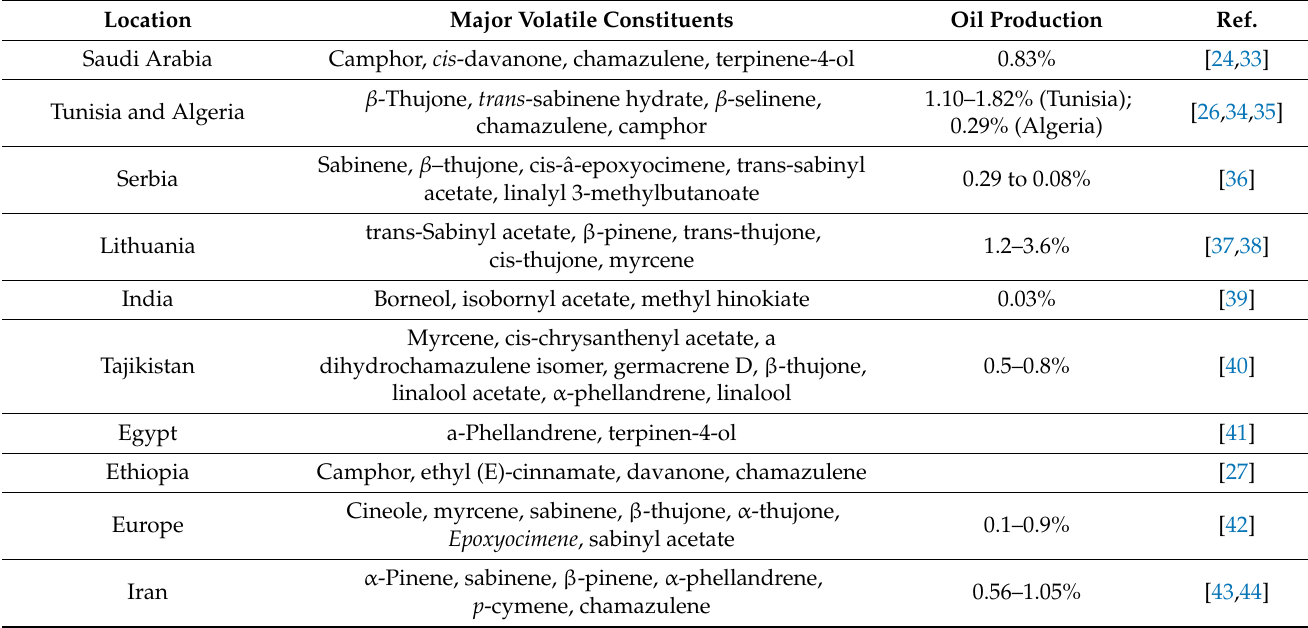
Table 1. Major volatile constituents of A. absinthium growing in different